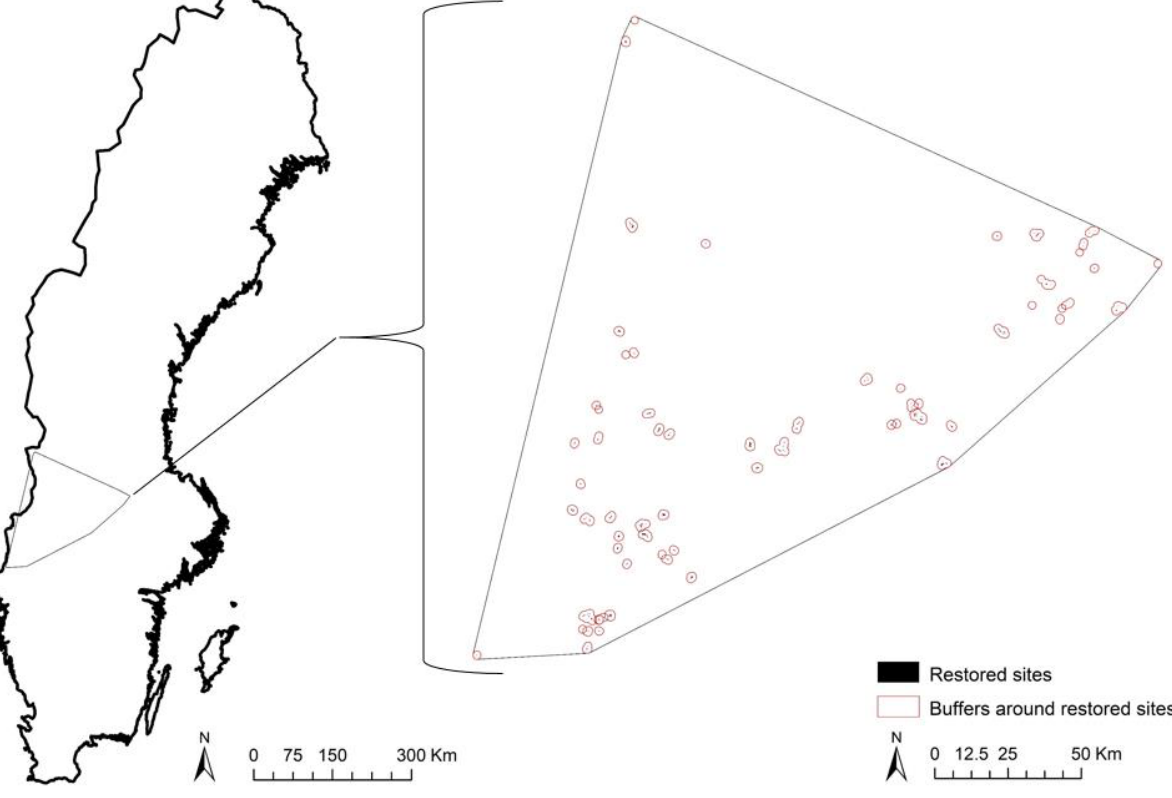
Figure 1. The location of the restored sites and their buffers (see main text) within Sweden used for the study. For the analyses we created five different geographic categories: first, the restored sites (category 1: R (Table 1)) and their accompanying buffer zones (category 2: B) as de-